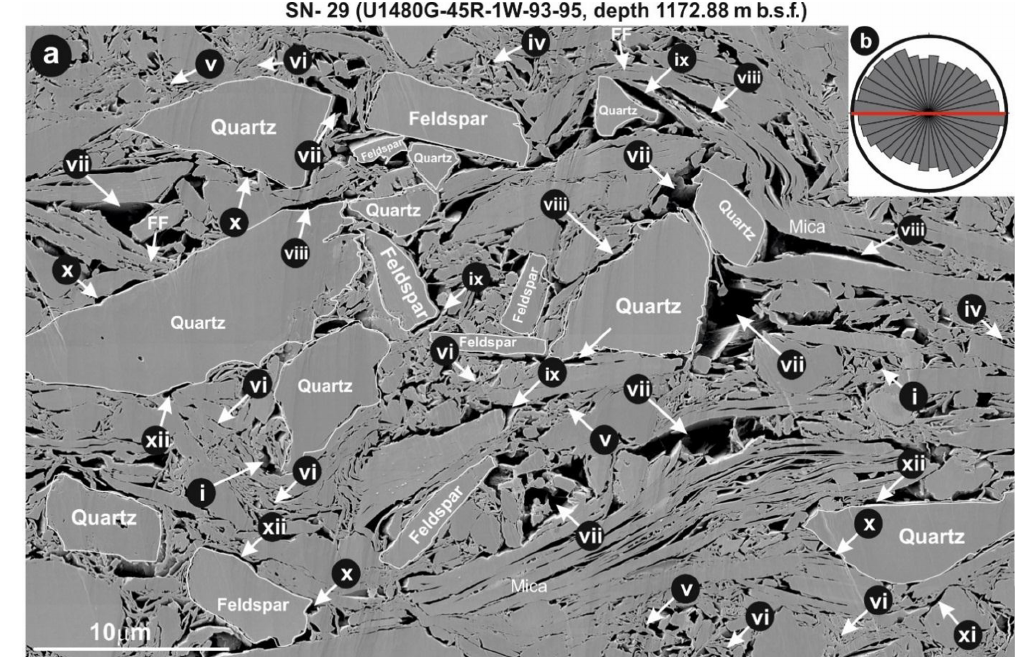
Figure 10. Silt-rich sample (SN-29; 1173mb.s.f.). In panel (a) , the following are indicated. (i) Equant large clay-domain pores, (ii) elon- gated large clay-domain pores, (iii) crescent-shaped large clay-domain pores, (iv) equant small clay-domain pores, (v) crescent-shaped small clay-domain pores, (vi) elongated small clay-domain pores, (vii) equant large silt-adjacent pores, (viii) elongated large silt-adjacent pores, (ix) crescent-shaped large silt-adjacent pores, (x) equant small silt-adjacent pores, (xi) crescent-shaped small silt-adjacent pores, (xii) elon- gated small silt-adjacent pores. (b) Rose diagram of long axes of pores (bedding: red line). FF: face-to-face contact of clay particles.